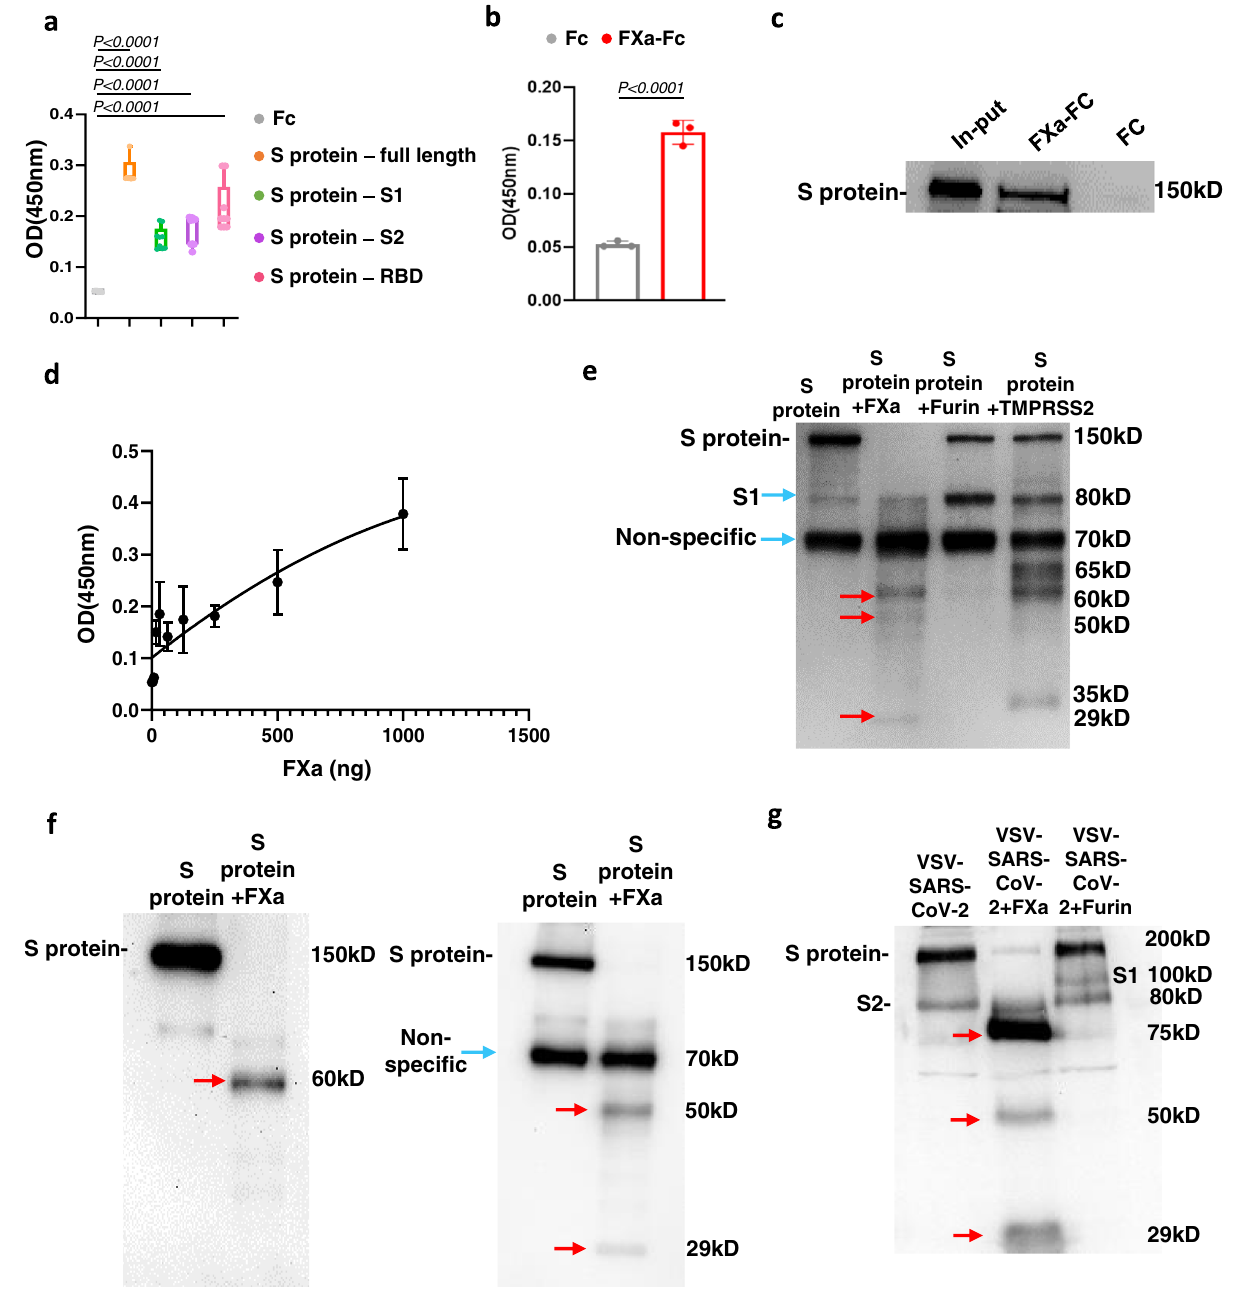
Fig. 2 | FXasuppressesviralentrybybinding to andcleavingtheSARS-CoV-2S protein. a The binding af fi nity of FXa with full-length wild-type S protein, subunit S1, subunit S2, or RBD was quanti fi ed by ELISA ( n =9 biologically independent samples). Bounds of box is from 25% percentile to 75% percentile, horizontal bar indicates median, and whiskers indicate data ranges. b The binding af fi nity of FXa to VSV-SARS-CoV-2 viral particles was quanti fi ed by ELISA ( n =3 biologically inde- pendent samples). c The interaction between FXa protein and full-length S protein was examined with a pull-down assay. d The binding af fi nity at indicated con-